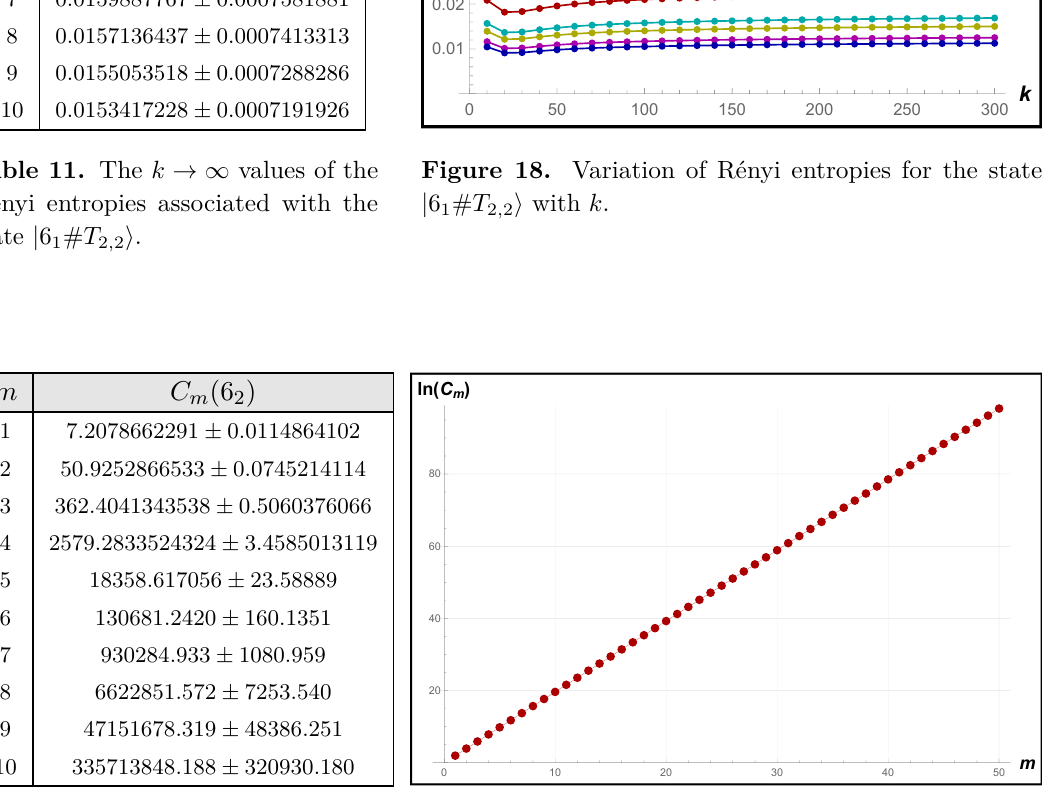
Table 12. Values of C m (6 2 ) . Figure 19. Variation of ln C m (6 2 ) with m